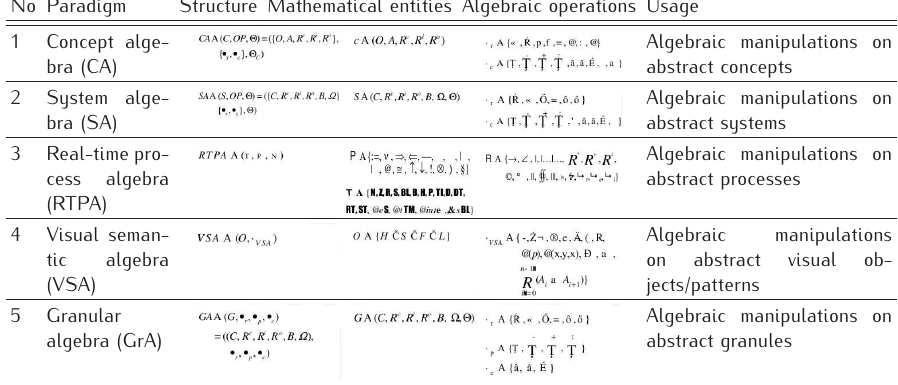
Table 2. Paradigms of Denotational